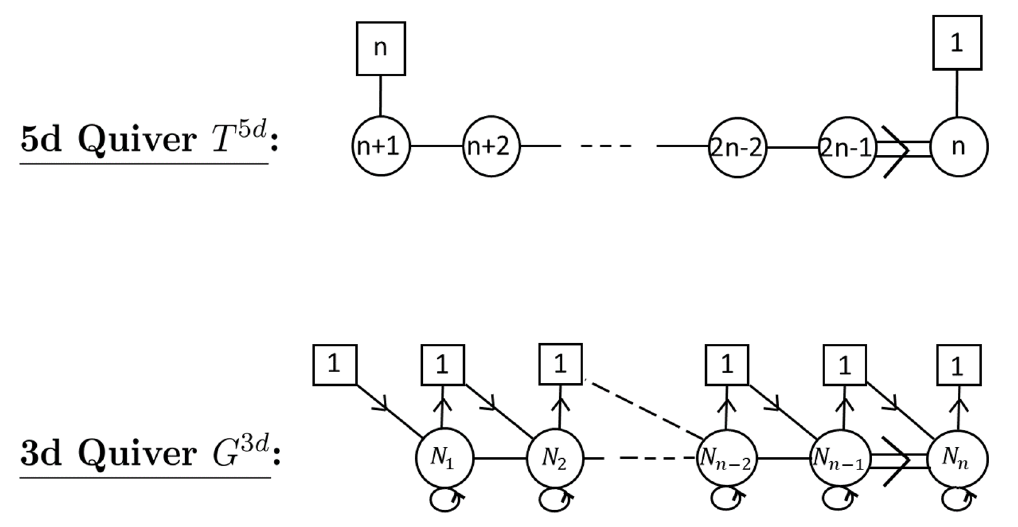
Figure 9. Sphere with 3 full B n punctures: 5d theory T 5d and 3d theory G 3d resulting from W S